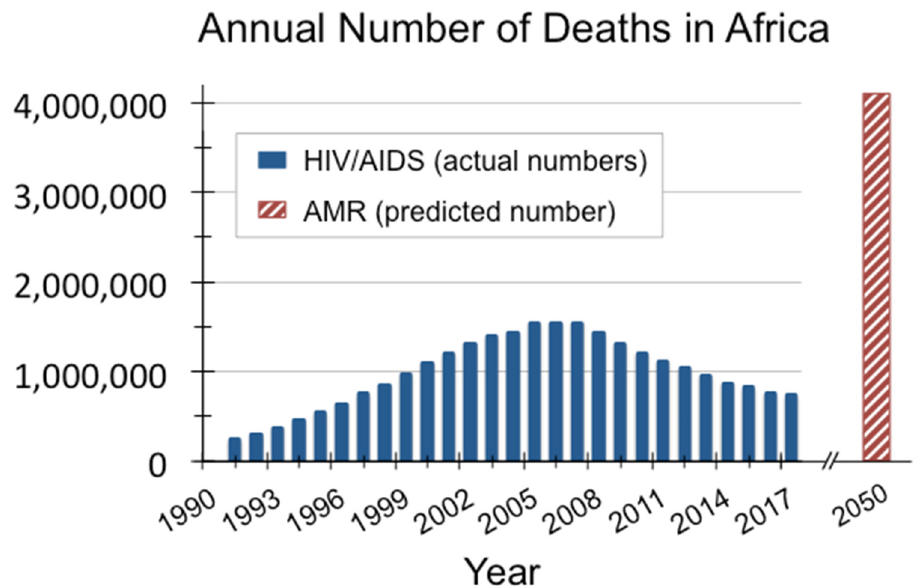
Figure 1. Africa was hardest hit by the HIV/AIDS crisis, and is expected to suffer the highest mortality per capita from AMR by 2050 [1,2].